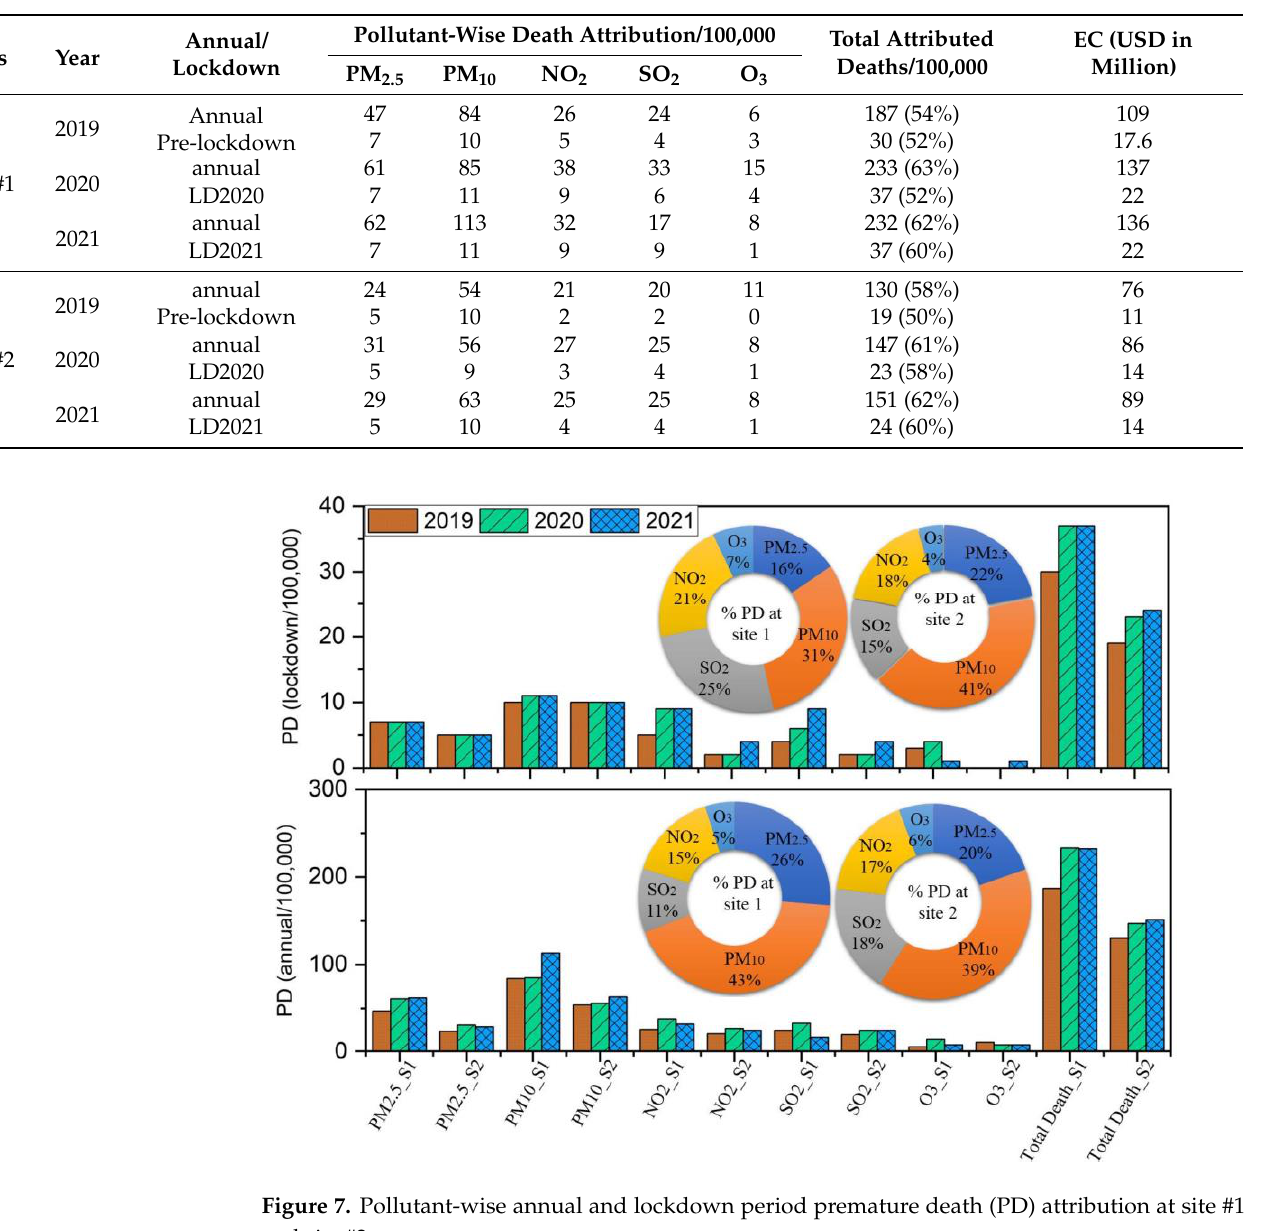
Table 2. Details of excessive risk, premature death attribution, and economic cost at site #1 and site #2.